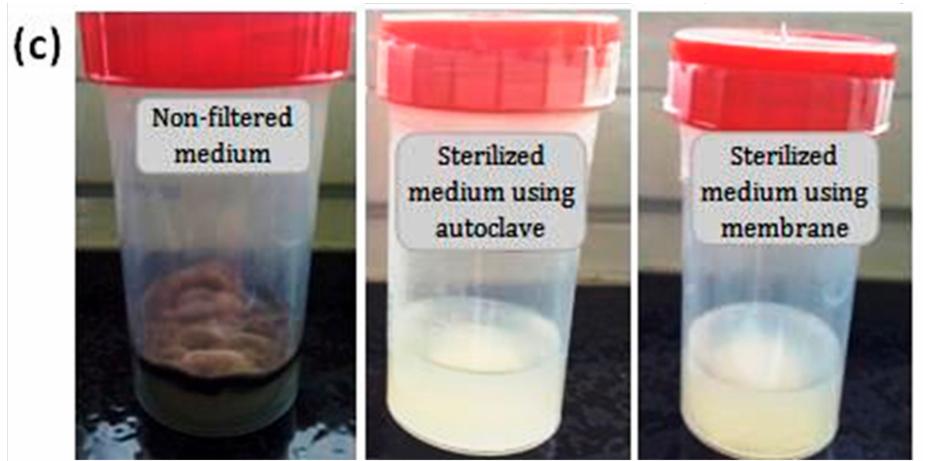
Figure 15. Photographs showing medium contamination variations versus time: ( a ) 5 days, ( b ) 15 days and ( c ) 30